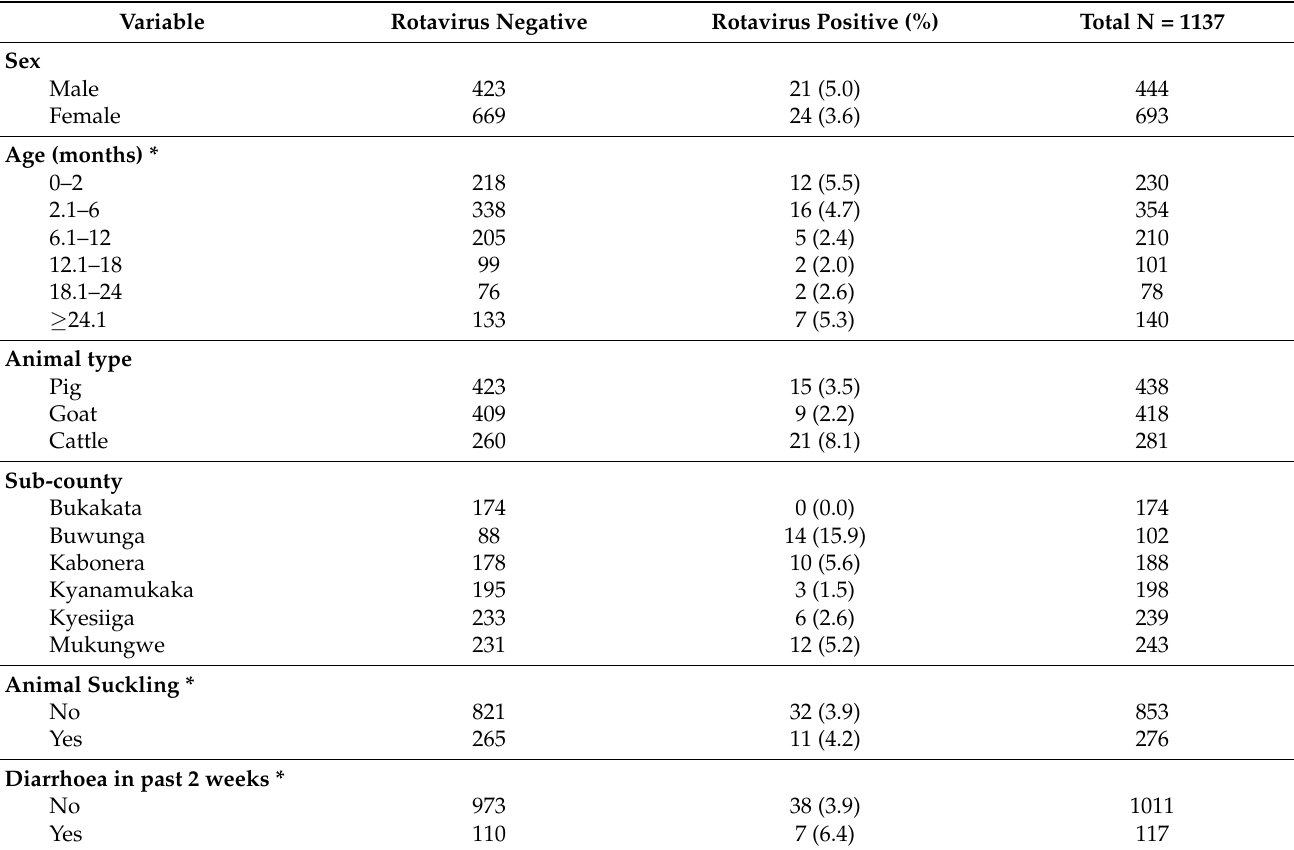
Table 1. Characteristics of the animals studied for Rotavirus infection in Masaka District, Central Uganda,